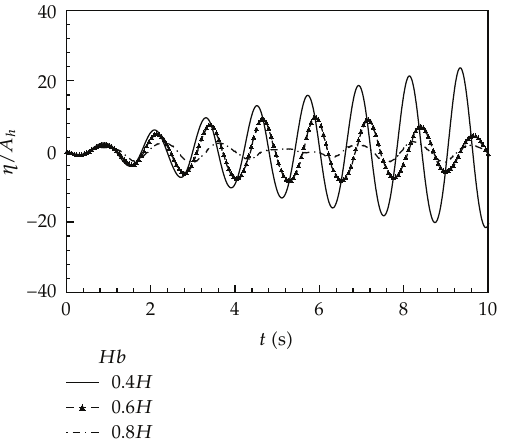
Figure 18: Time histories of wave surface at the left tank wall for D (cid:8) 0 .